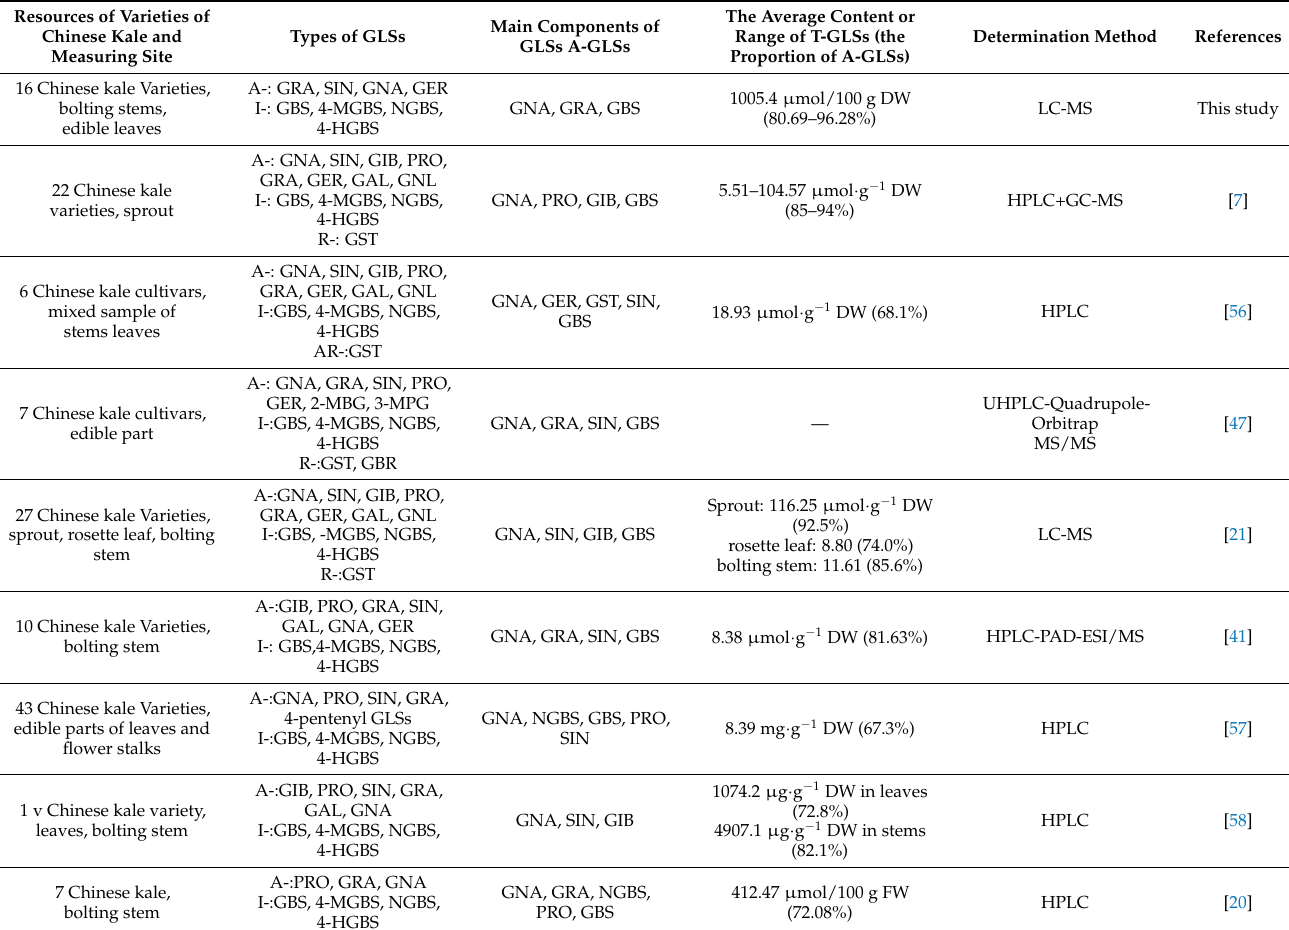
Table 6. The types, main components and content ranges of glucosinolates determined by different